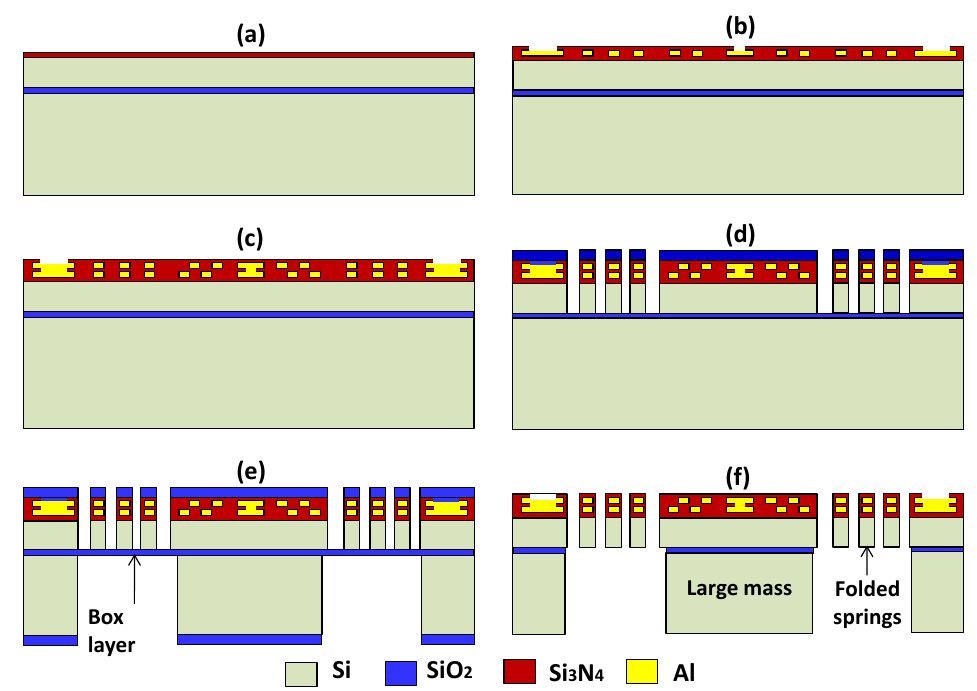
Figure 2. Microfabrication process of the EH array device. ( a ) Si 3 N 4 deposition; ( b ) patterning of the 1st metal and isolation layers; ( c ) patterning of the 2nd metal and isolation layers; ( d ) frontside deep reactive ion etching (DRIE); ( e ) grounding and backside DRIE; ( f ) etch